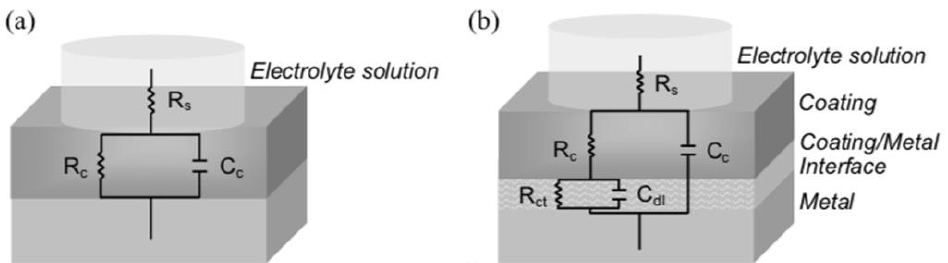
Figure 19. ( a ) A simple equivalent circuit illustration, known as Randle’s circuit. ( b ) An equivalent circuit considering the influence of the interphase [134].